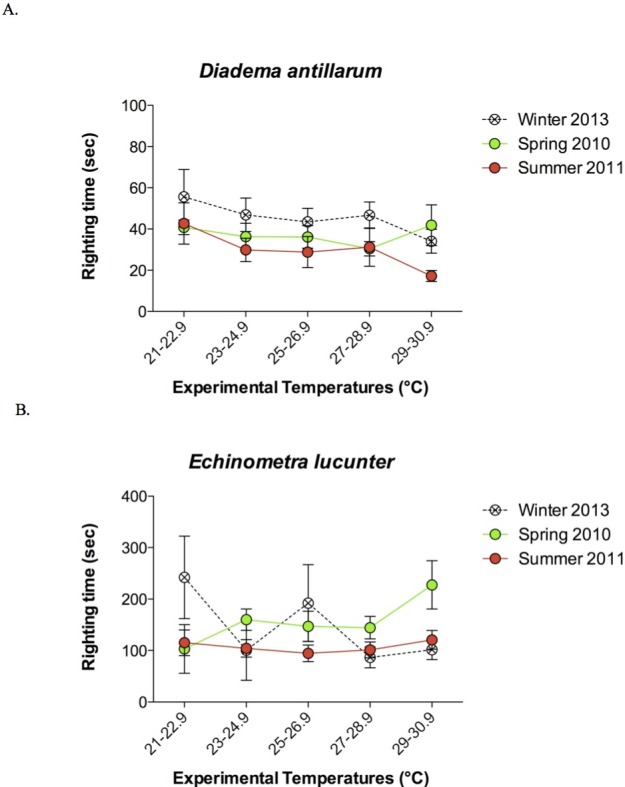
Mean righting times (±SEM) at increasing experimental temperatures (below TLoR) of (A) Diadema and (B) Echinometra collected during the winter, spring, and summer.For clarity, the data are displayed in bins of experimental temperatures of 1.9 °C. Species (p < 0.0001) and collection temperature (p = 0.025) significantly affected righting time but the temperatures at which the sea urchins were tested did not (p = 0.561). Model: F3,431 = 56.58; p < 0.0001; R2 = 0.28. Note that the y-axes are scaled differently.